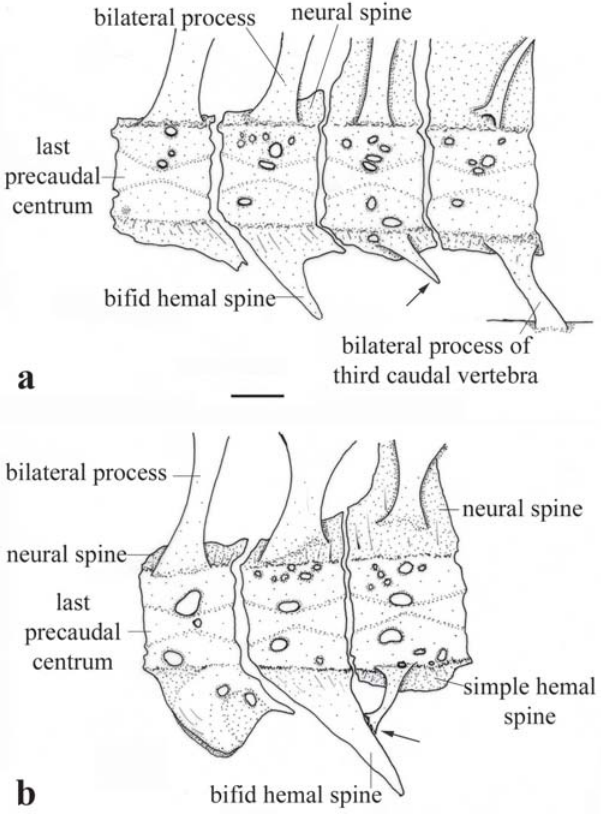
Fig. 42. Lateral view of part of the axial skeleton (right side) of Harttia loricariformis (MZUSP 66187, 67.7 mm SL) (a), and Lamontichthys llanero (INHS 29957, 105.2 mm SL) (b). Arrow points to distal portion of the parahemal spine of second caudal vertebra. Scale bar = 1